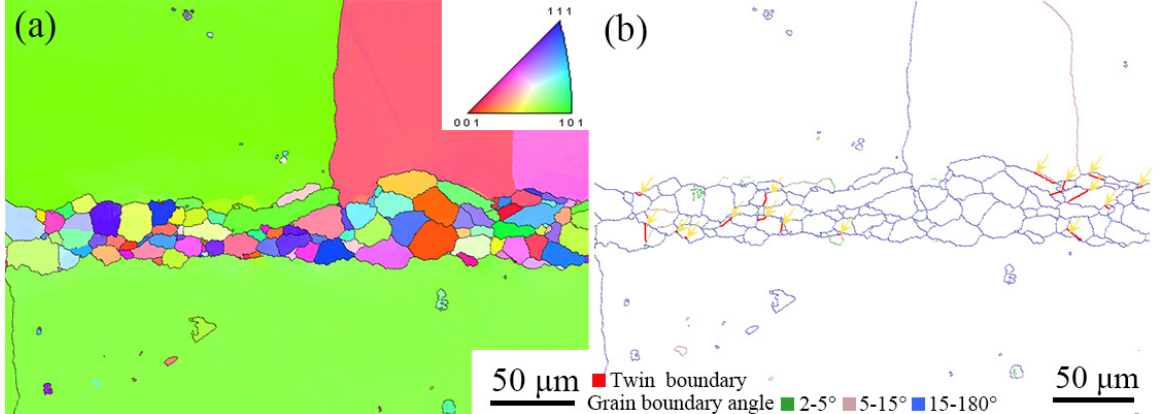
Figure 5. EBSD images of TLP-diffusion-bonded joint: ( a ) IPF image; ( b ) grain boundary angle dis- tribution.